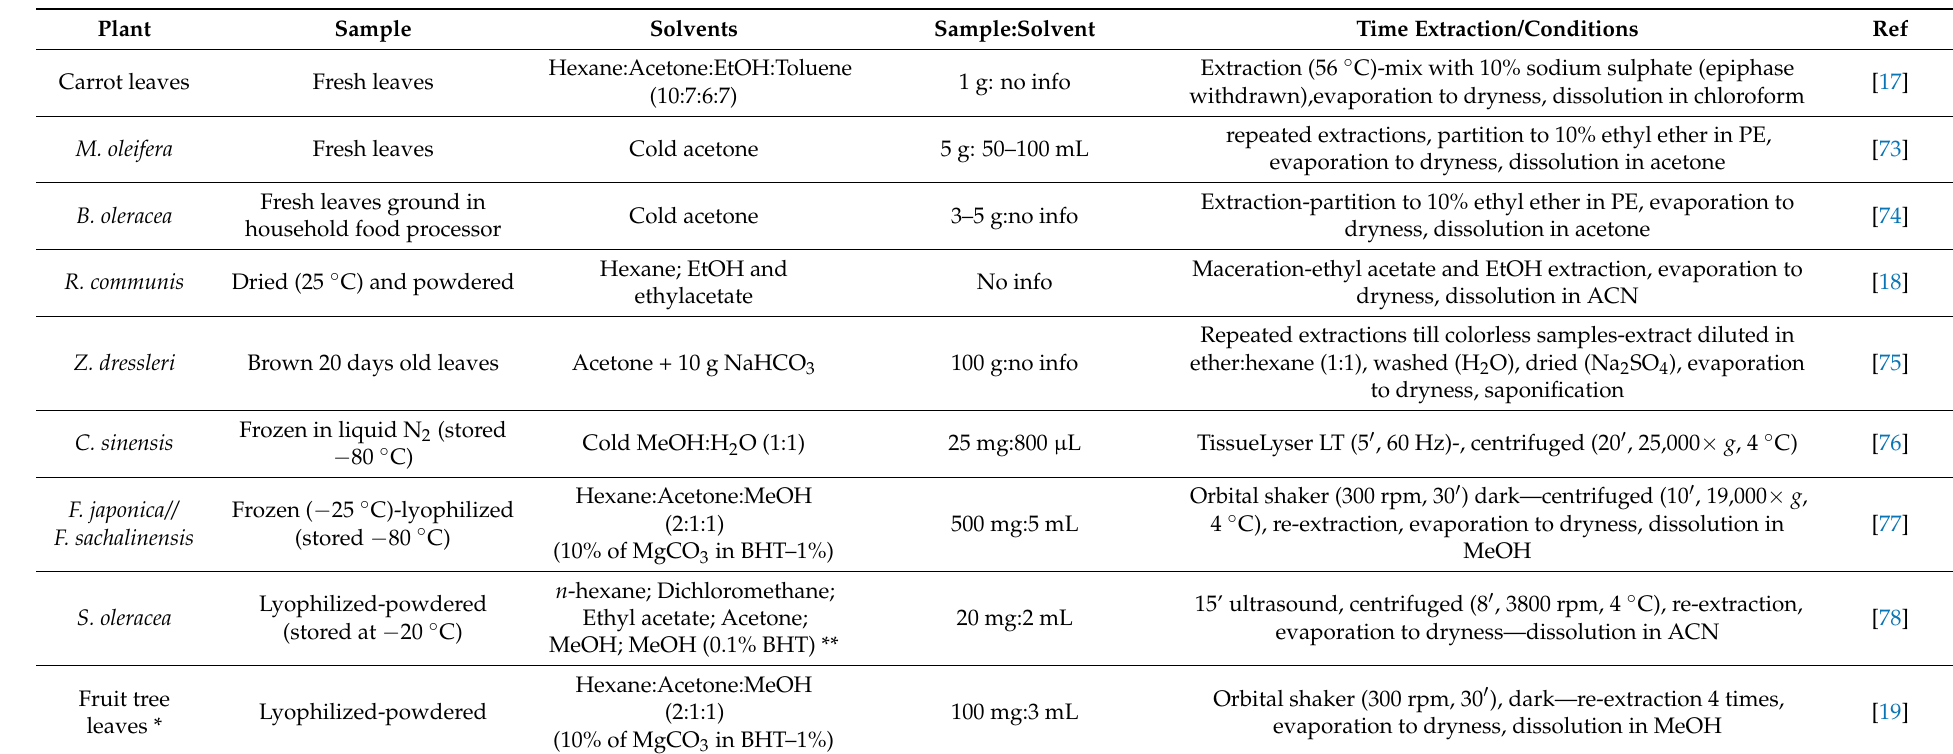
Table 4. Carotenoids—sample pre-processing and extraction